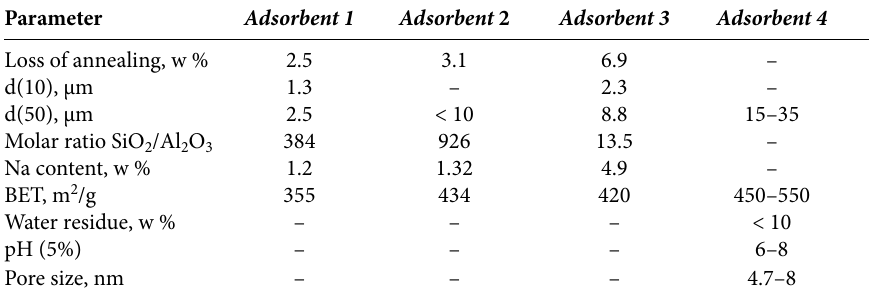
Table 1. Physical and chemical characteristics of Adsorbent 1, 2, 3 and 4 Parameter Adsorbent 1 Adsorbent